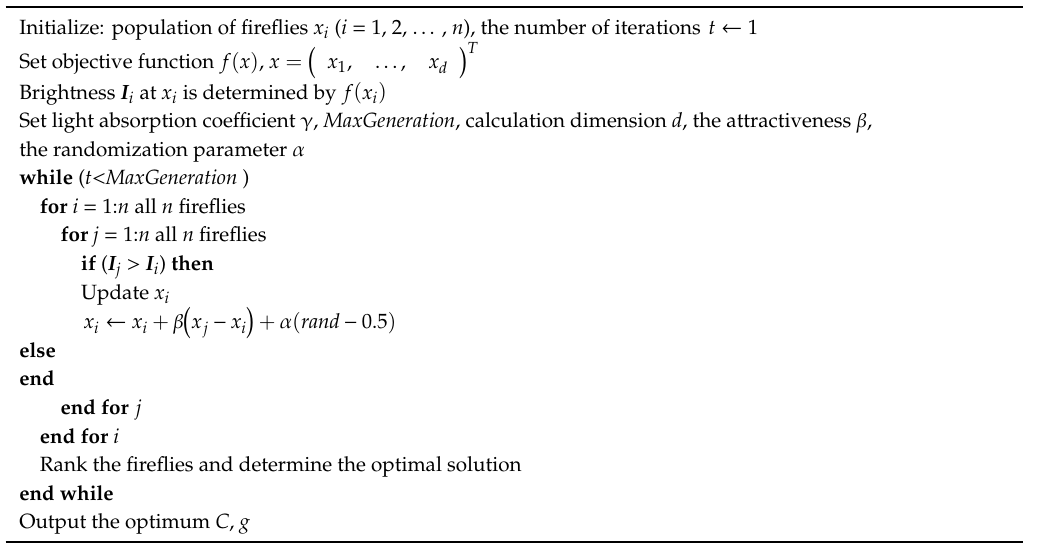
Algorithm 1. Algorithm of firefly algorithm (FA) optimization for kernel extreme learning machine (KELM).